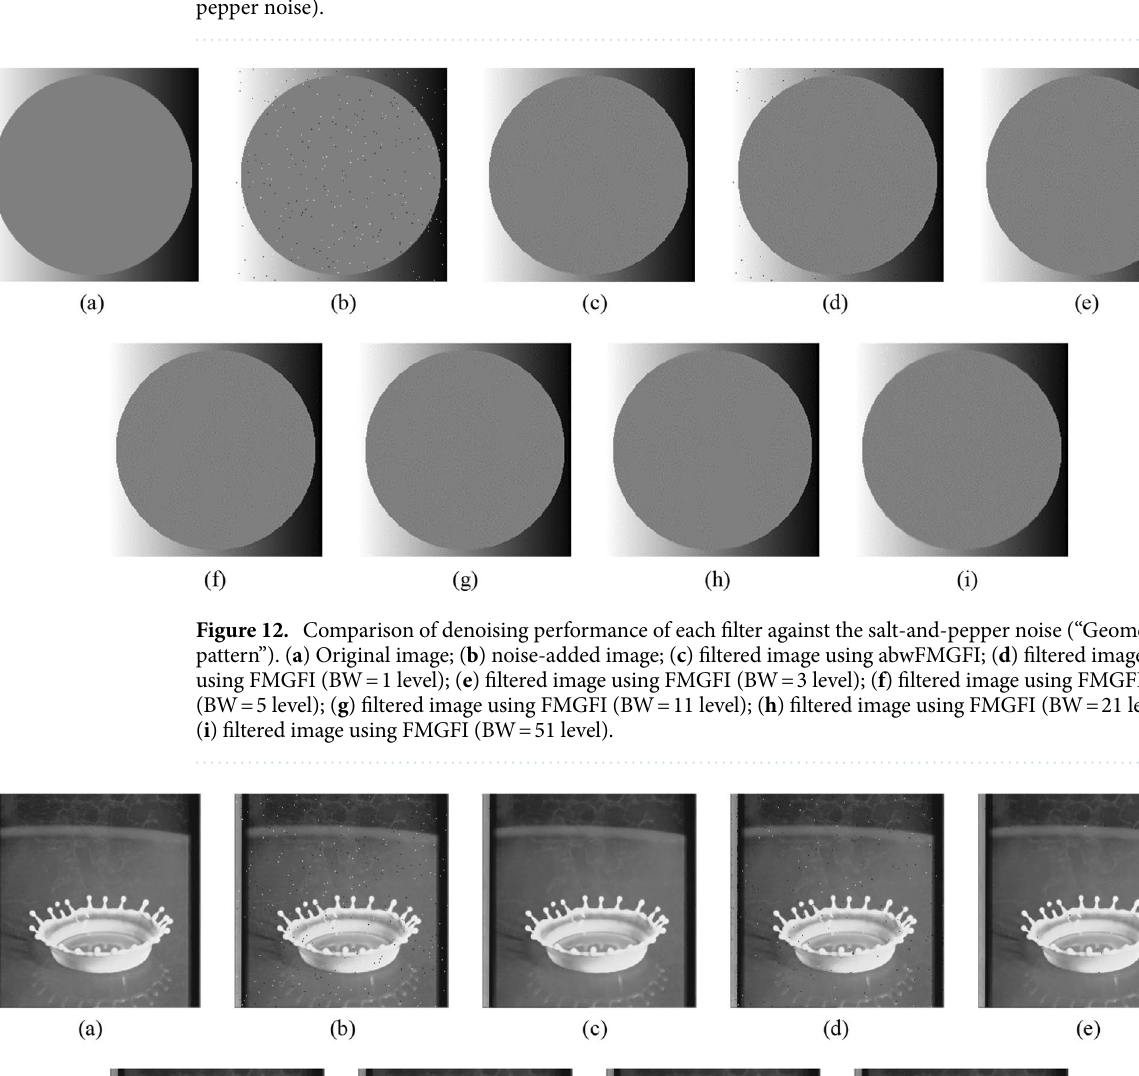
Table 4. Comparison of the SSIM values of each sample image filtered using each filter (against the salt-and- pepper noise).